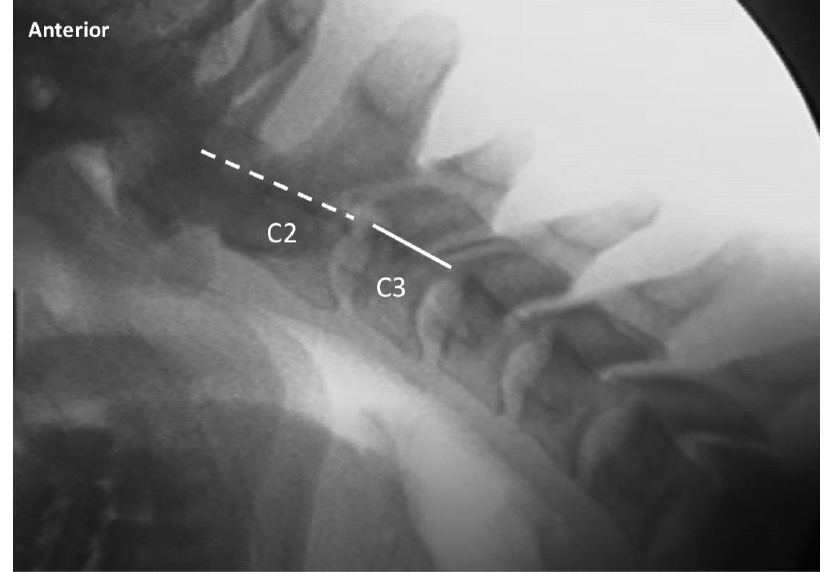
Figure 3. Exemplar of lateral cervical flexion view, demonstrating normal alignment of C2 on C3. The dashed line indicates the posterior margin of the vertebral body of C2, and the solid line indicates the posterior margin of the vertebral body of C3. The 2 lines are aligned, indicating normal alignment of C2 on C3 upon maximal voluntary flexion.